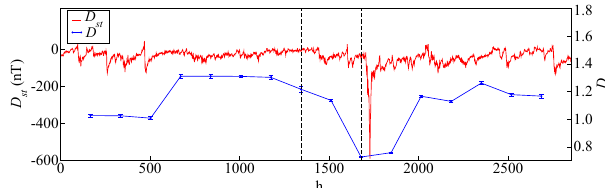
Figure 5. Box-counting dimension D (blue) and Dst index (red) for the 13 March 1989 geomagnetic storm. D decreases before the storm in the windows within the vertical lines. (Taken from Domínguez et al.,